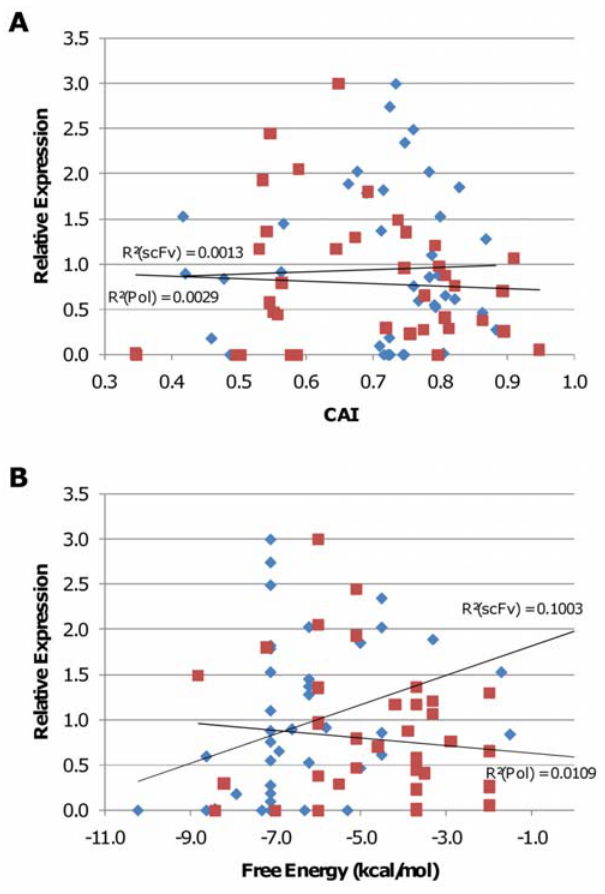
Figure 3. Expression is not predicted by Codon Adaptation Index or mRNA structure. The codon adaptation index [7] (part A) and the strength of mRNA secondary structure from position 2 4 to + 38 relative to the initiating AUG (part B) were calculated for each variant synthesized in this study and plotted against the expression level measured for that variant. Blue diamonds indicate scFv variants. Red squares indicate polymerase variants. Expression levels are normalized to highest expressing variant for each set (equal to 3).